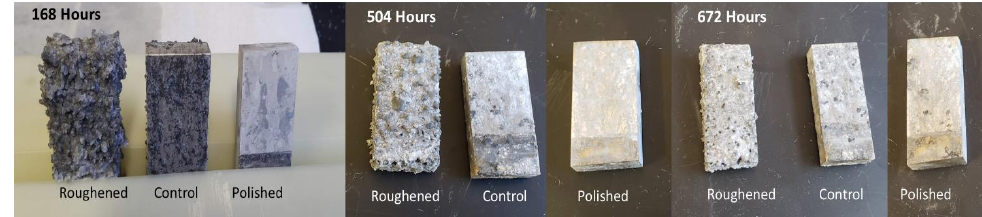
Figure 3. Pictures of the samples were taken to show the change in oxide layer formation over the course of the experiment. All three photo sets show minimal change to the surface of the polished sample. At 168 h the roughened sample had significant growth of a hydrated oxide layer. This layer is also present on the control sample, but significantly less. As the h increased, the amount of hydrated layer growth decreased and a hard oxide layer becomes more